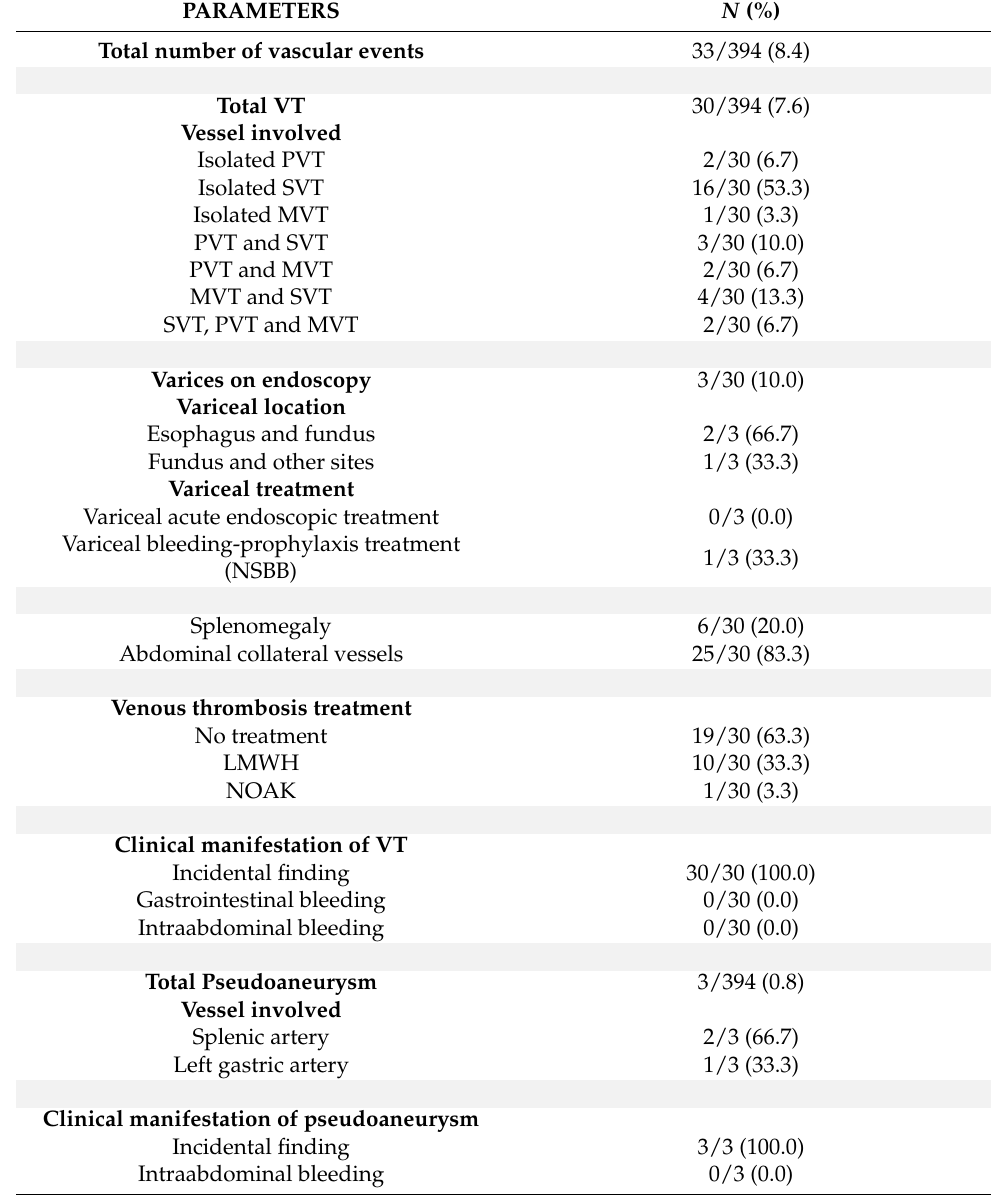
Table 1. Distribution, clinical manifestations and treatment modalities of vascular events (venous thrombosis or